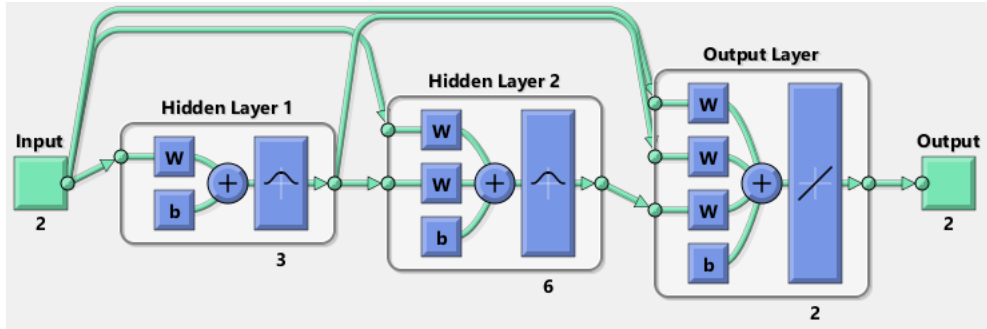
Figure 4. Architecture of the selected